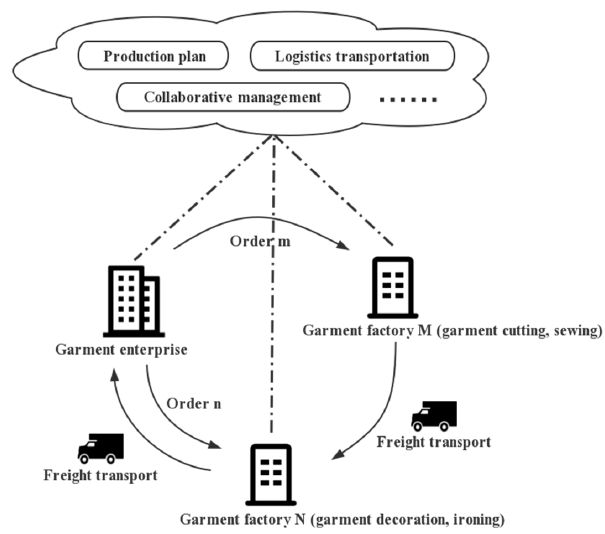
Figure 8. Schematic diagram of a virtual joint factory formed by a garment enterprise and outsourcing processing factories.